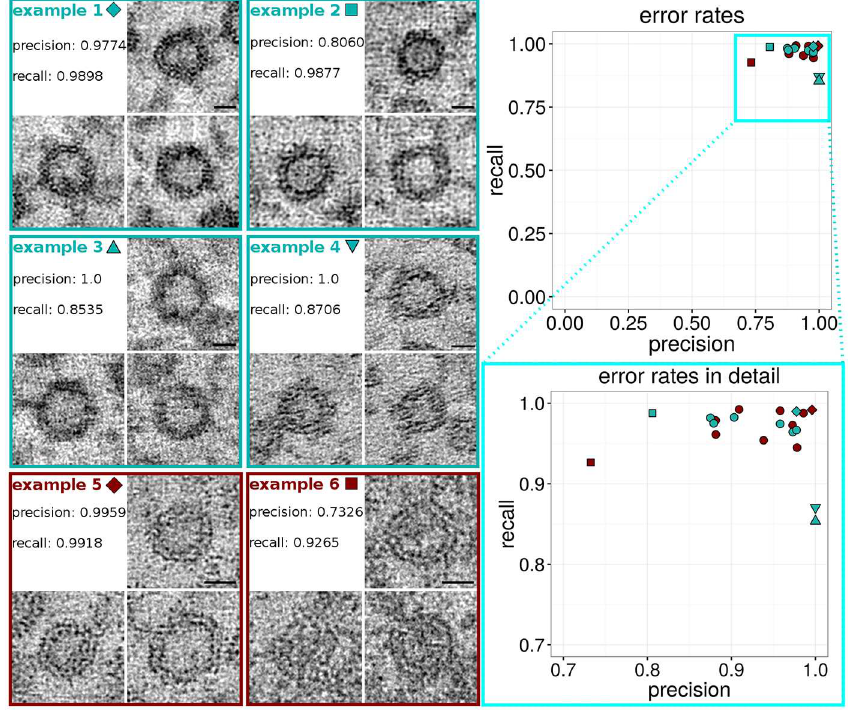
Fig 5. On the right, upper side a dot plot is shown, representing zebrafish (turquoise) as well as C . elegans (dark red) error rates. Each dot representsprecisionand recall of one tomogram (magnifieddetail plot on the lower right side). Tomograms that are shown as exampleson the left side of the figure are represented as a specialsign (e.g. triangleor square) insteadof a round dot in the plot. On the left side, example1 shows vesicles of a high qualitytomogram, with good results for recall (low number of false negatives)and precision(low number of false positives). In comparison to one tomogram with worse precision (example2) and two tomograms (example3 and 4) with a higherrate of false negativevesicles, i.e. lower recall. Furthermore, examples5 and 6 show vesicles of one tomogram with best precisionand recall rate (example5) in comparisonto one tomogram with very low precision. Scale bars: 20